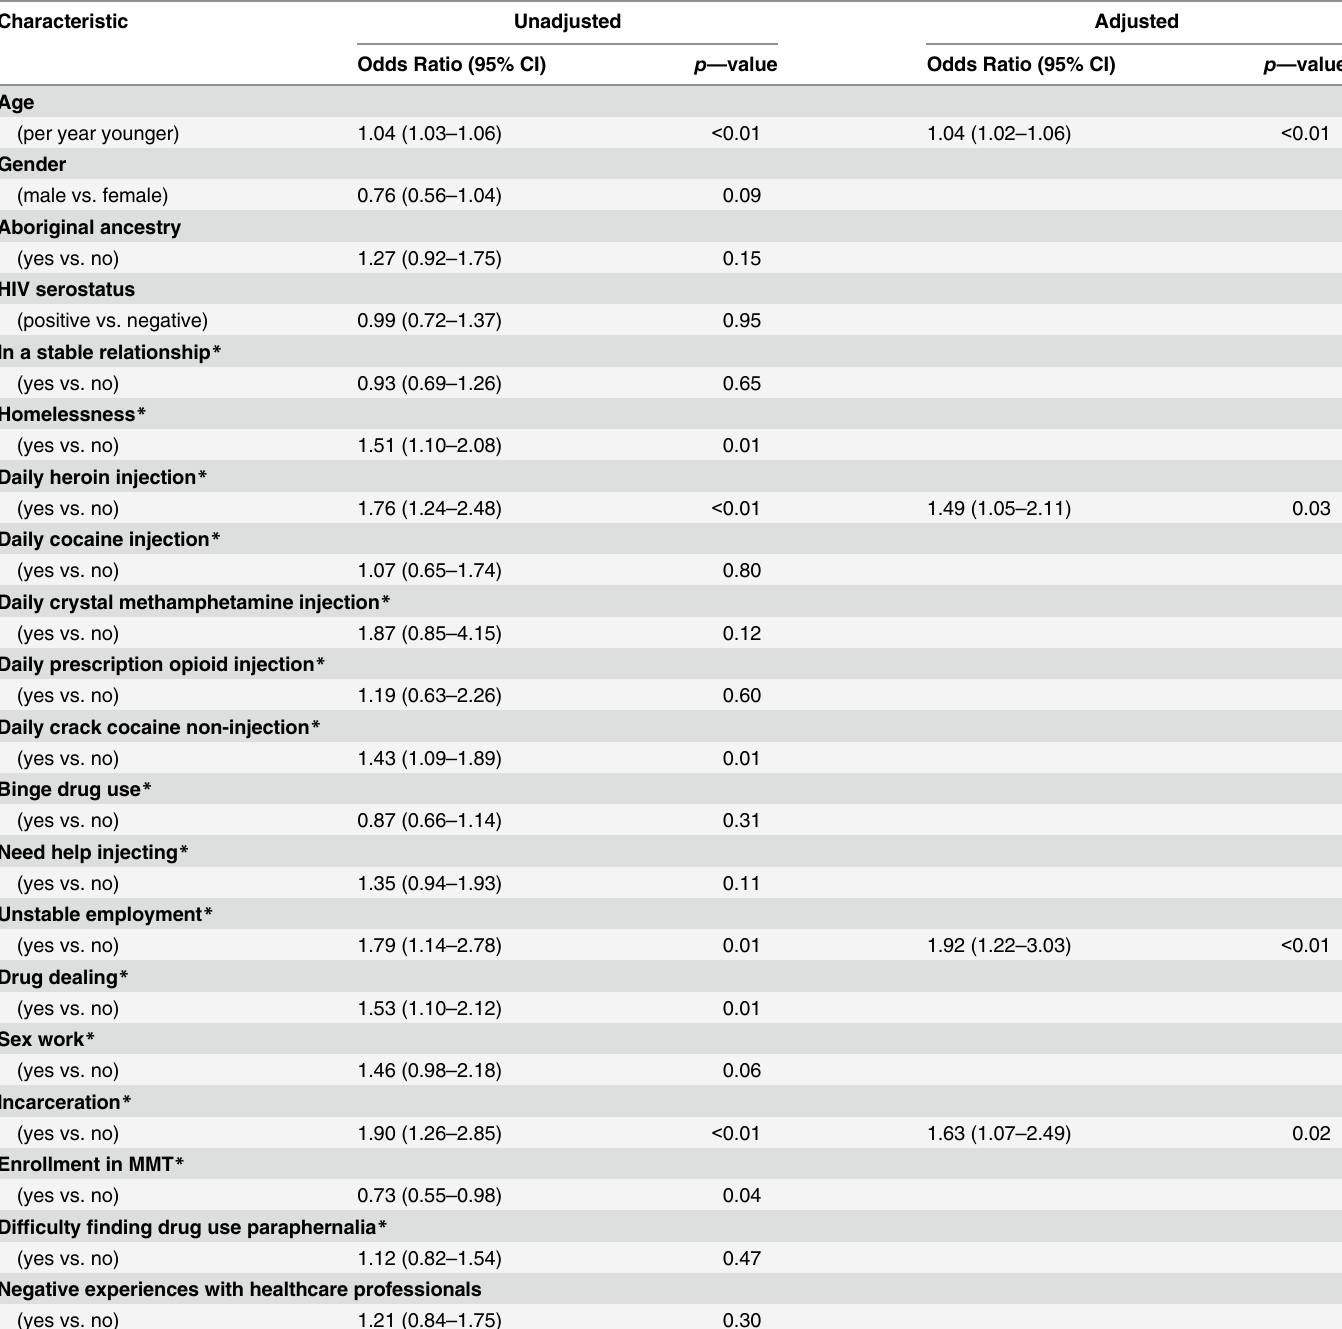
Table 2. Bivariable and multivariable GEE analysis of factors associated with leaving hospital against medical advice among hospitalized people who use illicit drugs (n = 488).